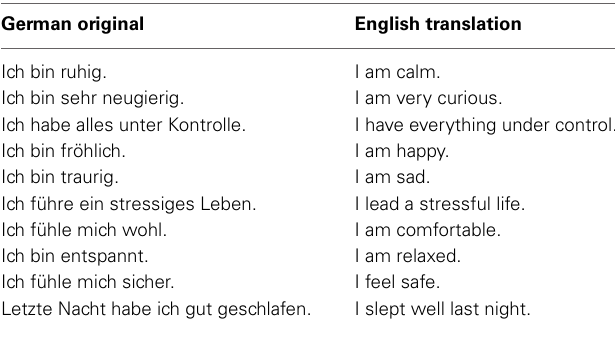
Table A3 | Statements used in the emotion ratings. German original English